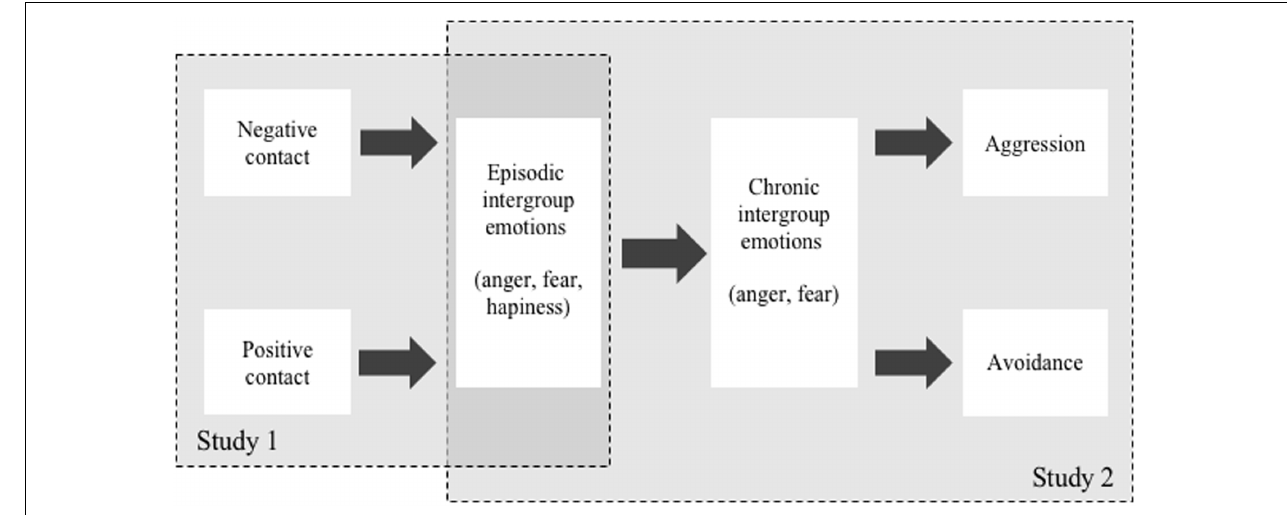
FIGURE 1 | Theoretical model to be tested in Studies 1 and